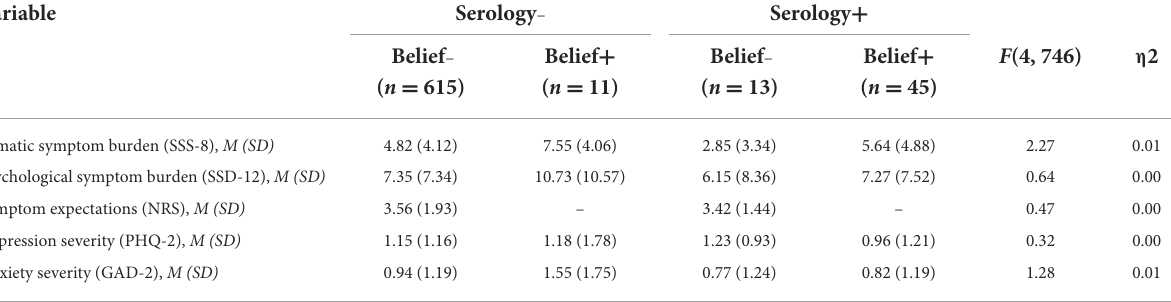
TABLE 3 Comparison between groups differing in terms of SARS-CoV-2 serology and self-reported belief of SARS-CoV-2 infection on study variables at T1 ( n = 684).